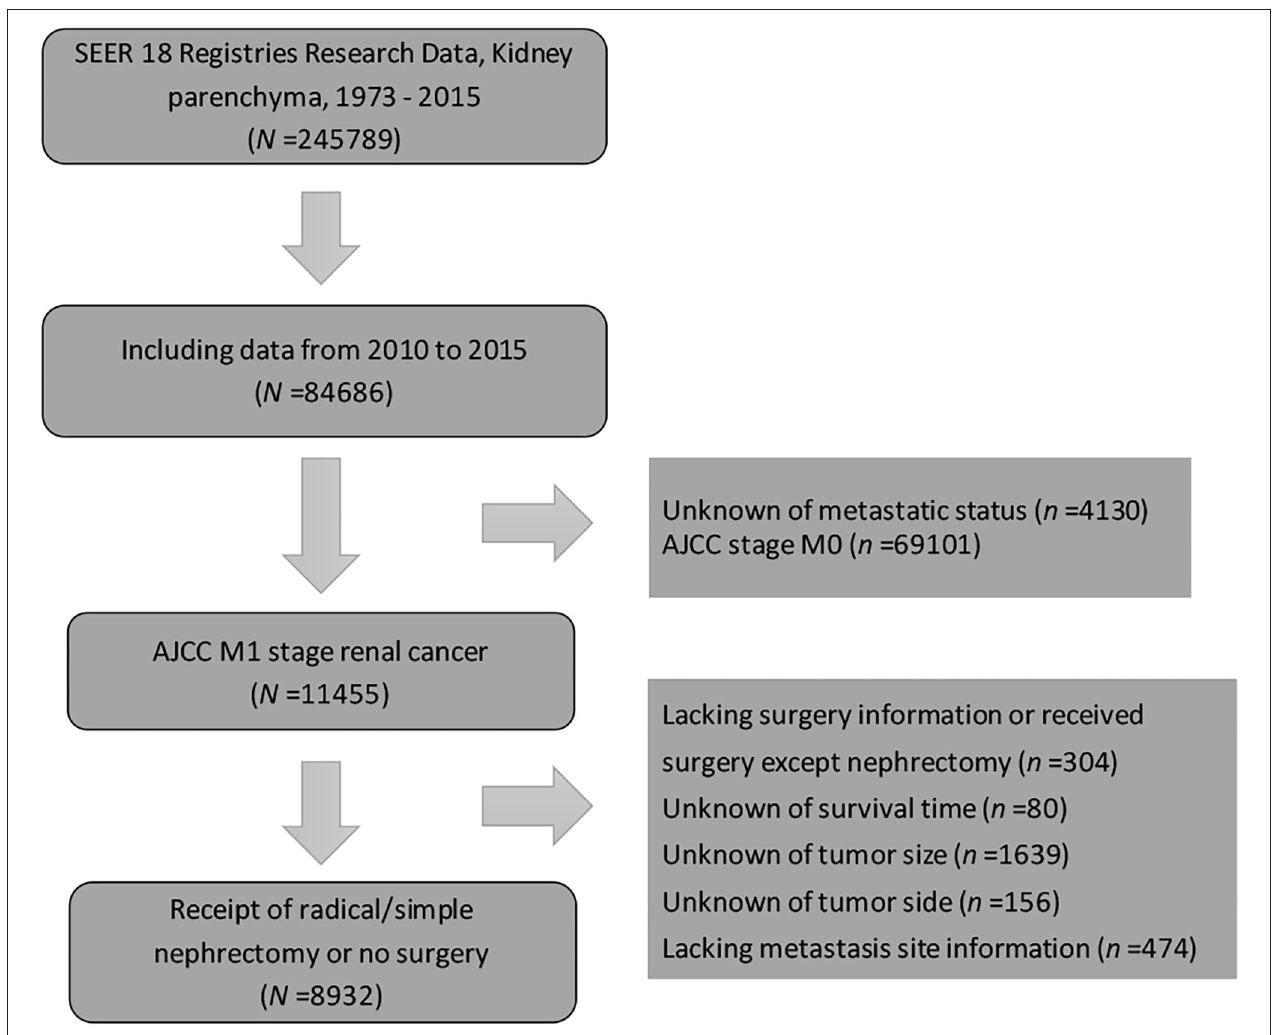
FIGURE 1 | Study population diagram. Patient selection flowchart. AJCC, American Joint Committee on cancer; SEER, Surveillance, Epidemiology, and End